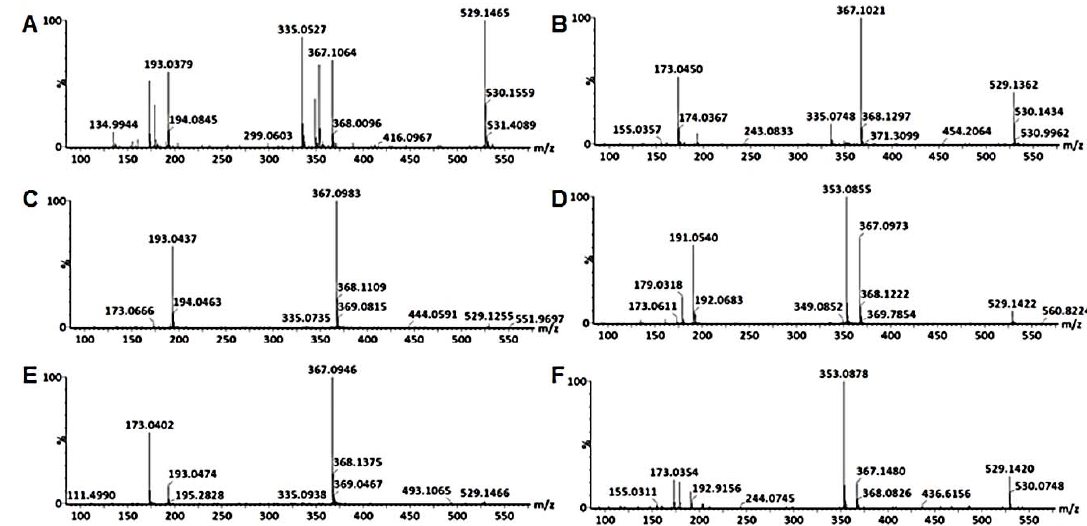
Figure 5. Typical mass spectra of the fragmentation patterns of 3 ‐ feruloyl ‐ 4 ‐ caffeoylquinic acid (A) , 3 ‐ caffeoyl ‐ 4 ‐ feruloylquinic acid (B) , 3 ‐ feruloyl ‐ 5 ‐ cafffeoylquinic acid (C) , 3 ‐ caffeoyl ‐ 5 ‐ feruloylquinic acid (D) , 4 ‐ feruloyl ‐ 5 ‐ caffeoylquinic acid (E) , and 4 ‐ caffeoyl ‐ 5 ‐ feruloylquinic acid (F).